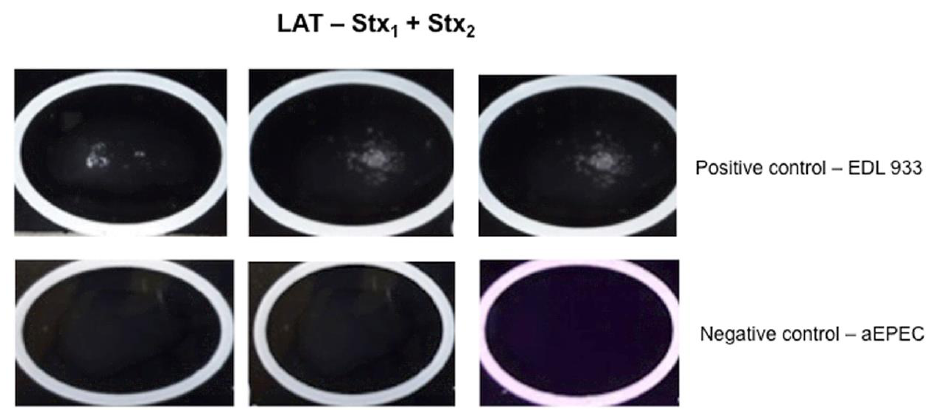
Figure 5. Representative image of positive (EDL 933 – O157:H7) and negative (atypical EPEC–aEPEC – O127:H7) controls strains in a latex agglutination test (LAT) employing Stx 1 and Stx 2 antibodies. Triplicates of each experiment.